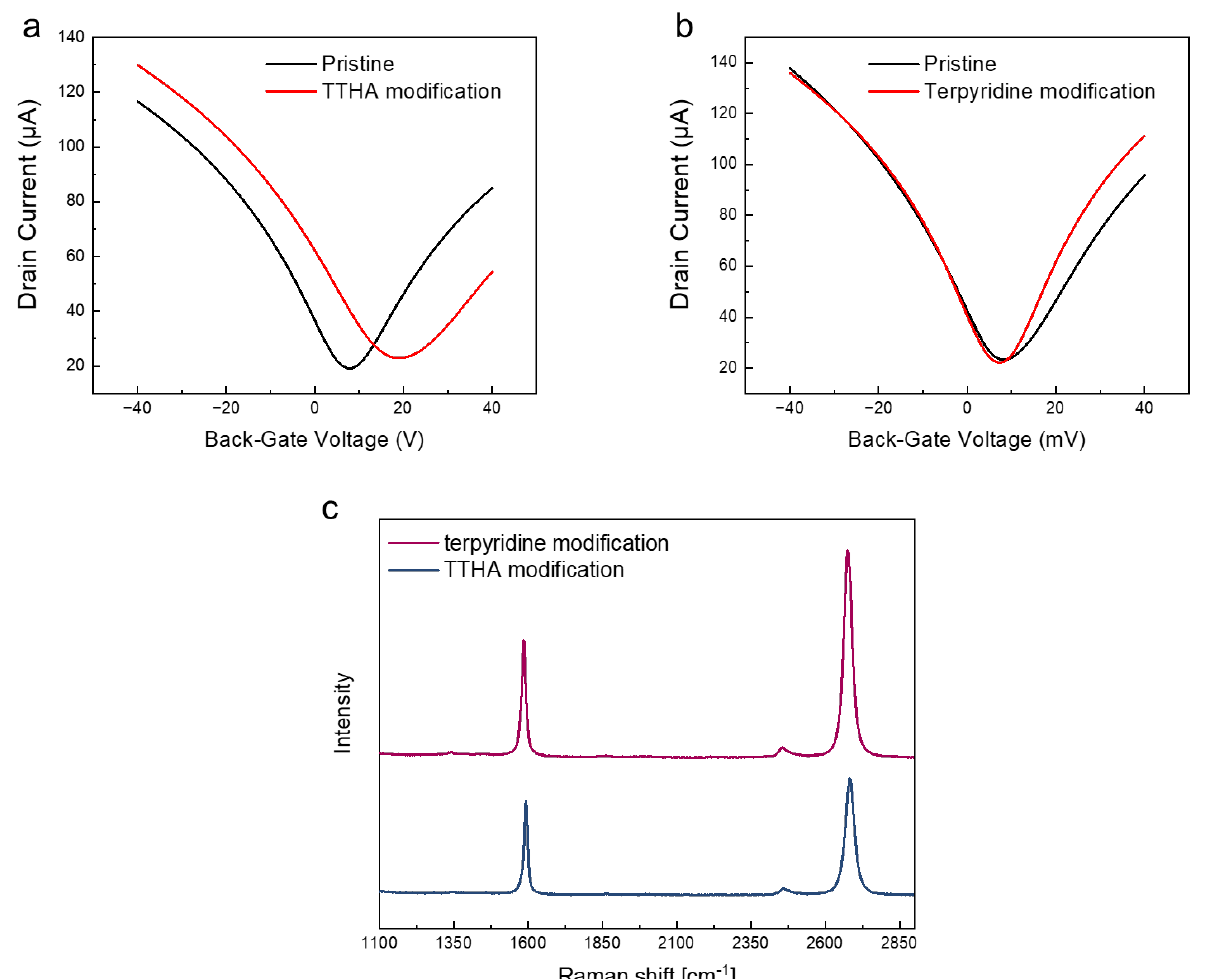
Figure 3. ( a , b ) Transfer characteristics of graphene-based sensor before and after TTHA and terpyri- dine modification, respectively. ( c ) Raman spectra of the TTHA- (indigo) and terpyridine-modified (carmine) graphene-based sensor on a Si/SiO 2 substrate. Each spectrum is normalized by the G peak intensity.